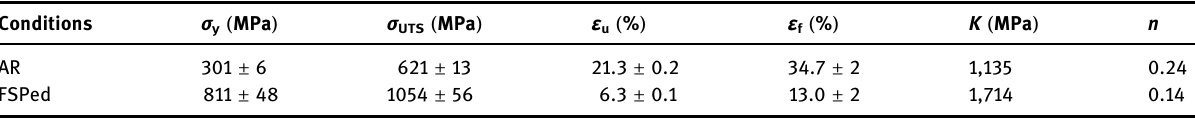
Table 1: Mechanical properties of AR and FSPed DP600 steel